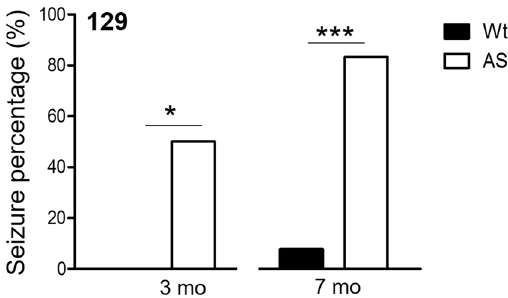
Figure 6. 129 AS mice were vulnerable to audiogenic seizures and exhibited wild running and tonic-clonic seizures when exposed to 140 dB sound in an enclosed chamber. The AGS phenotype affected a greater percentage of mice in the 7 mo old age group when compared with younger 3 mo old mice (n = 11–13 / group). Fisher’s test was used for analysis of seizure percentage at each designated age; n = 11–12 mice/group; * p < 0.05, *** p <